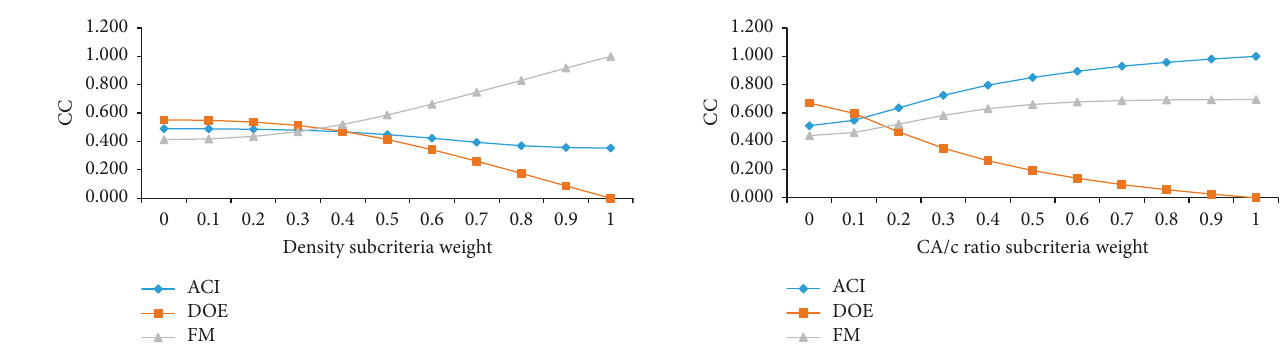
Figure 6: Sensitivity analysis of mix design methods with respect to density